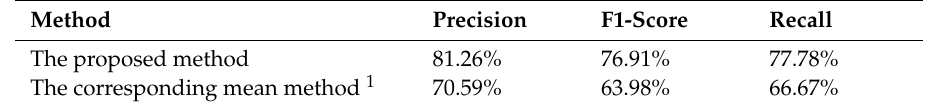
Figure 9. The spatial distribution of the remaining analysis units. Table 5. Classification accuracy results of the compared method.